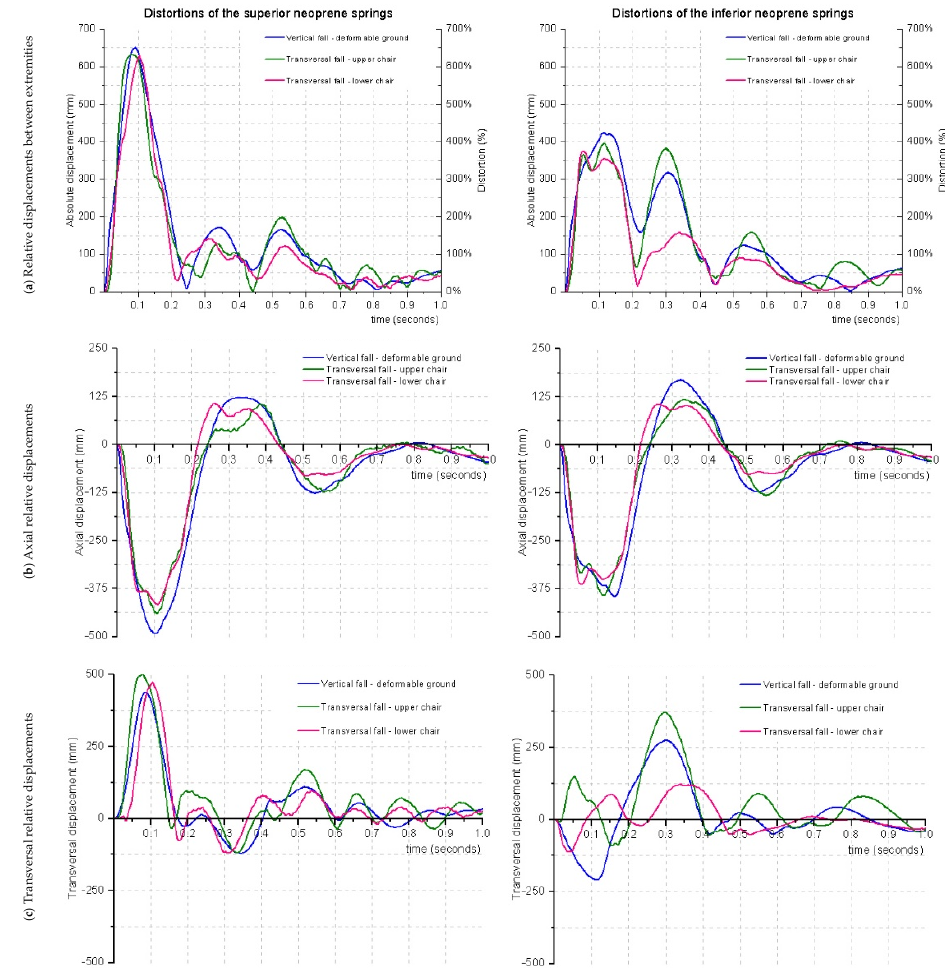
Figure 17. Displacements of the top (superior) and bottom (inferior) neoprene springs (fall situation 1 to situation 3).